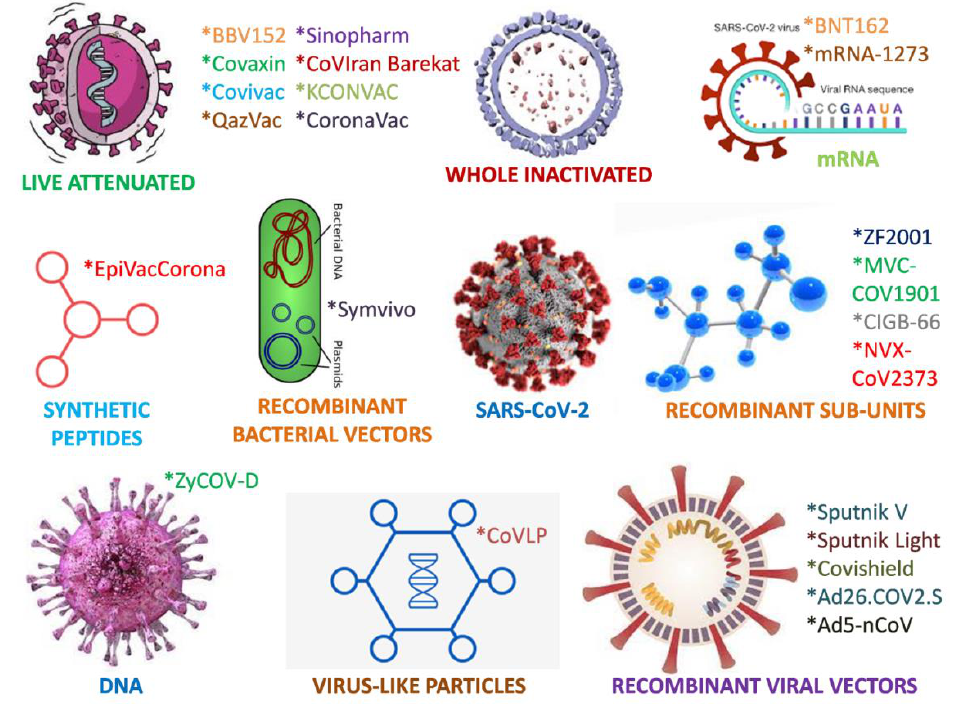
Figure 1. Various types of coronavirus vaccines and their examples.